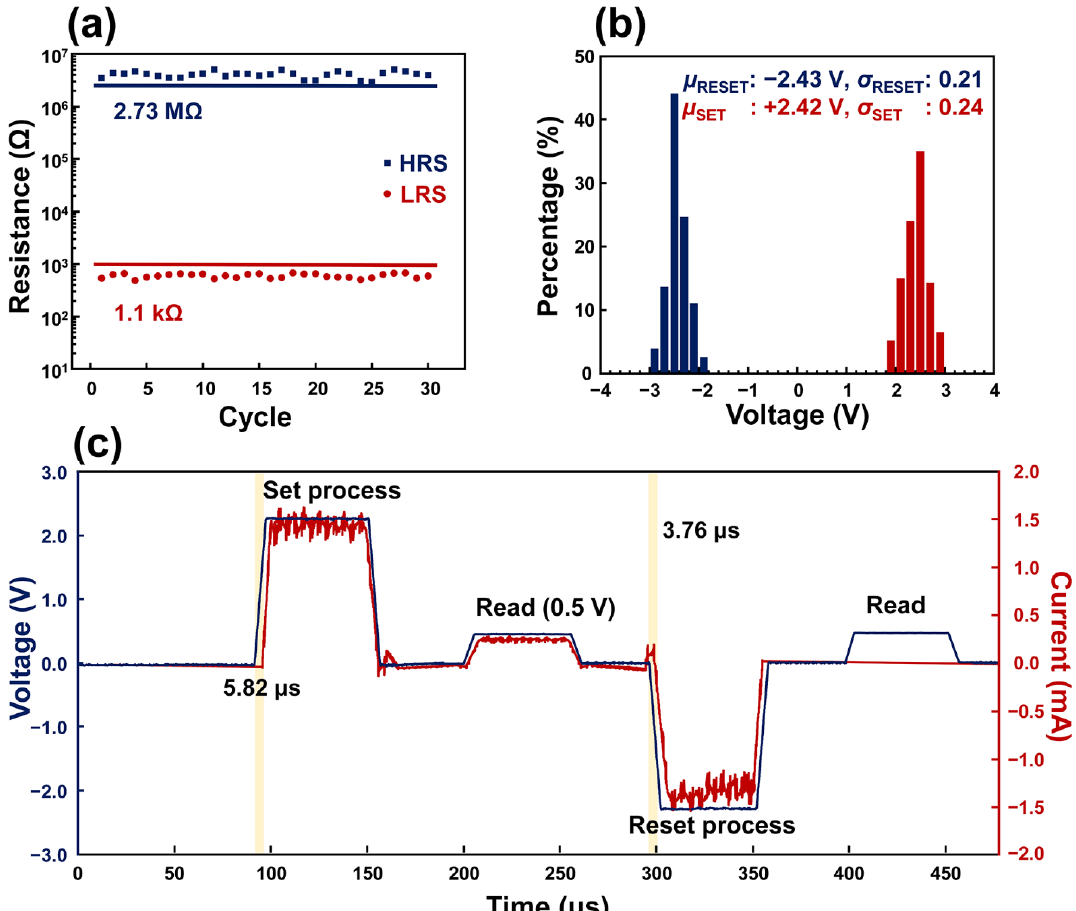
Figure 2. ( a ) Endurance characteristics of the Al/PDA/Al structure coated with a PDA layer for 2 h. ( b ) Percentage distribution of V Set and V Reset in 196 (14 × 14) Al/PDA/Al structures coated with a PDA layer for 2 h, and their mean values and standard deviations. ( c ) Typical pulse response of Al/PDA/Al structure with order of set, read, reset, and read pulses. Figure 3a,b depict surface images obtained by conductive atomic force microscopy (C-AFM) to confirm the distribution of the conductive filament (C.F) formed at the PDA layer when the PDA/Al structures coated with PDA layers for 2 and 3 h were in the HRS state. The size of the investigated area was 5 μ m × 5 μ m, respectively. When a bias voltage of 3 V was applied to each PDA/Al structure, conductive filaments were observed only in the PDA/Al structure coated with a PDA layer for 2 h. On the other hand, the absence of a conductive filament in the PDA/Al structure coated with a PDA layer for 3 h indicated that resistive switching did not occur. When a bias voltage of 5 V was applied to the PDA/Al structure coated with a PDA layer for 3 h, conductive filaments can be observed, as shown in Figure 3b. These results followed a trend similar to that of the V Set described in Figure 1e. This increment in the voltage required to induce resistive switching can be explained by the increased thickness of the PDA layer due to a longer PDA coating time. Prior to formation of a conductive filament, the fabricated structure was in the HRS state because the PDA layer acted as an insulating layer. When a sufficient electric field is ap- plied to a PDA insulator layer, soft breakdowns can occur in the PDA insulator layer, resulting in the formation of conductive filaments. Because an electric field is affected by both voltage and distance, the thickness of a PDA layer can affect the amplitudes of V Set and V Reset , which induce resistive switching. To apply the same electric field to the